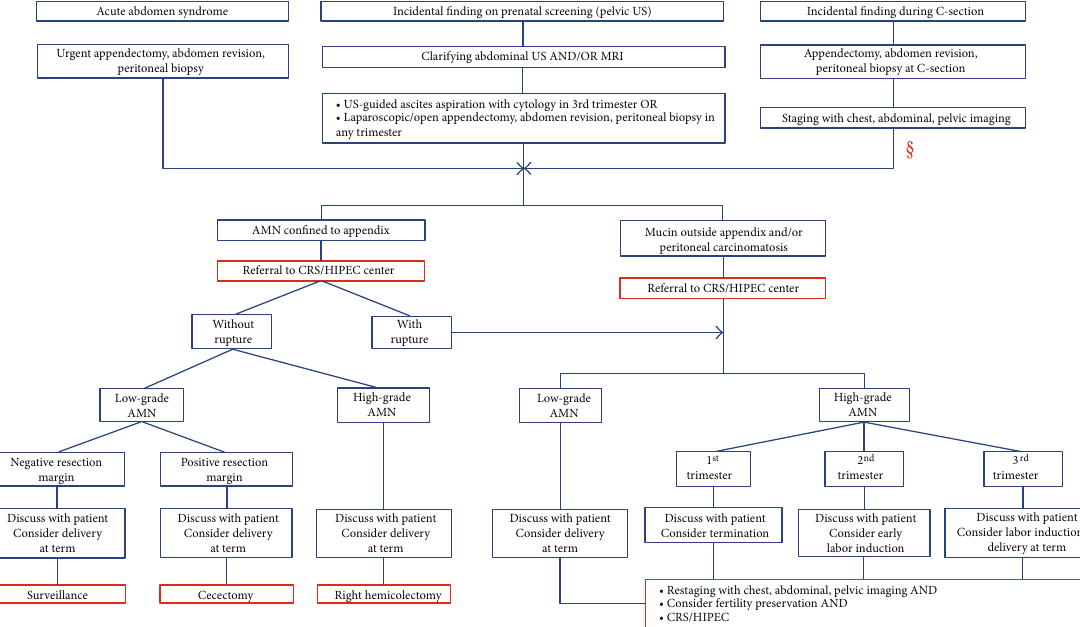
Figure 3: Algorithm of appendiceal mucinous neoplasm management diagnosed during pregnancy. § The algorithm here is consistent with that for the fi rst two scenarios except pregnancy management. AMN: mucinous appendiceal neoplasm; CRS/HIPEC: cytoreductive surgery with hyperthermic intraperitoneal chemotherapy; C-section: cesarean section; MRI: magnetic resonance imaging; PC: peritoneal carcinomatosis; US: